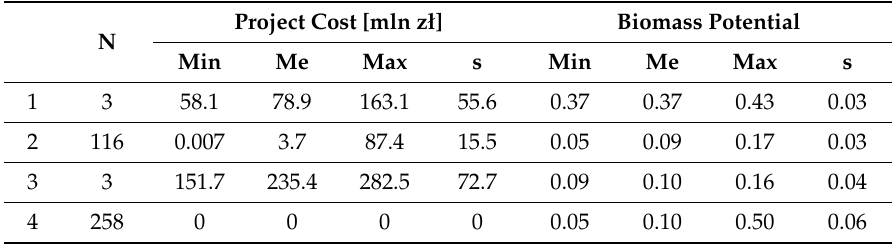
Table 4. Descriptive statistics for biomass energy